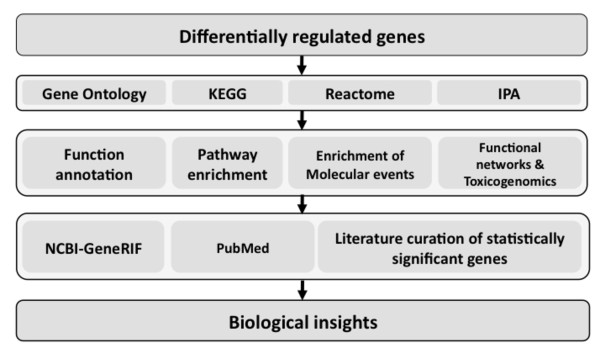
Bioinformatics pipeline used for the biological interpretation of differentially expressed genes.